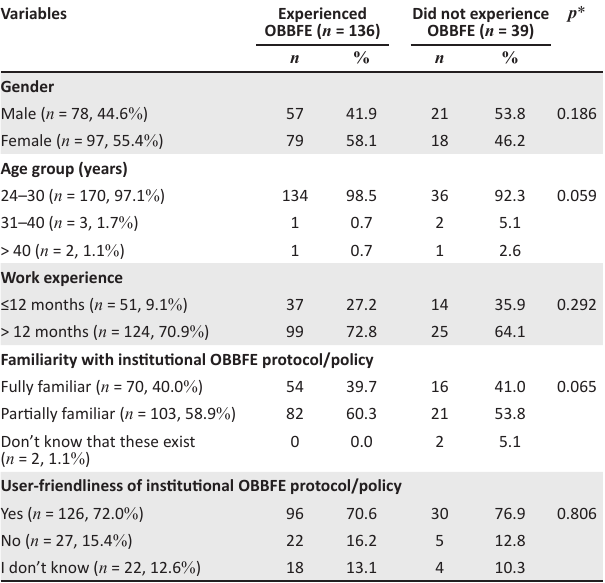
TABLE 1: Description and comparison of gender, age group, work experience as well as the familiarity and user-friendliness with institutional occupational blood and body fluid exposure protocols/policies between subjects who had and those who had not experienced an occupational blood and body fluid exposure.